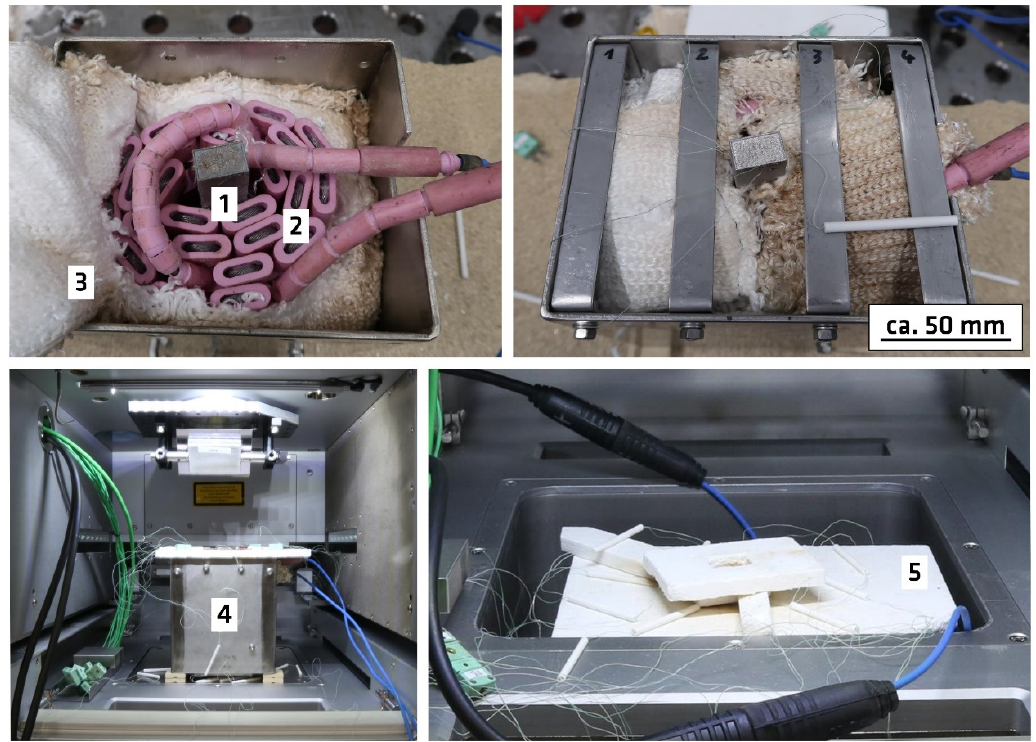
Figure 5. Photographs of mounted heating device: L-PBF reference specimen ( 1 ); heating mat ( 2 );